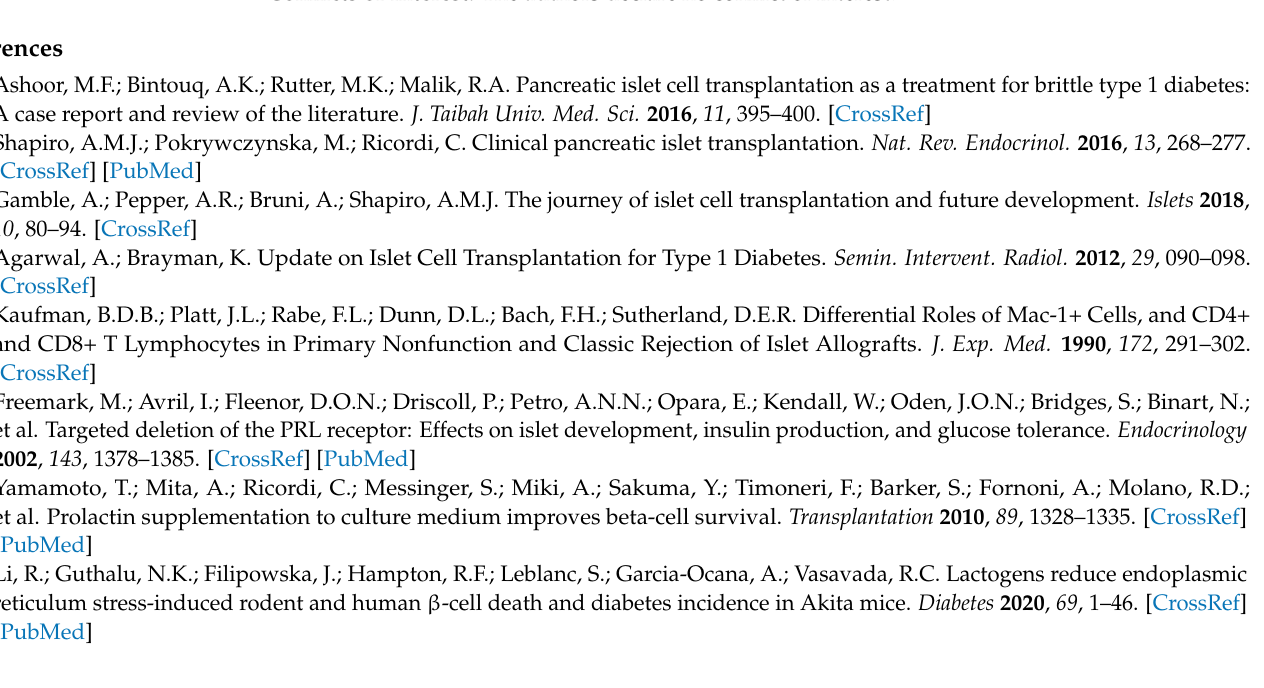
the UPR in Min6 cells under ER stress induced by proinflammatory cytokines or tunicamycin; Sup- plementary Figure S3. Increased HSPB1 expression modulates PERK and IRE1 α phosphorylation in mouse islets under ER stress induced by proinflammatory cytokines or tunicamycin; Supplementary Figure S4. The presence of HSPB1 promotes a longer survival of murine pancreatic beta-cell with in- hibited proteasome; Supplementary Figure S5: HSPB1 levels modulate global protein ubiquitination in Min6 cells; Supplementary Figure S6: Uncropped